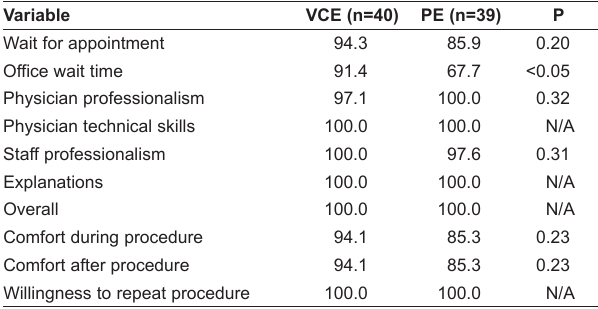
TABLE 5 Postprocedural patient